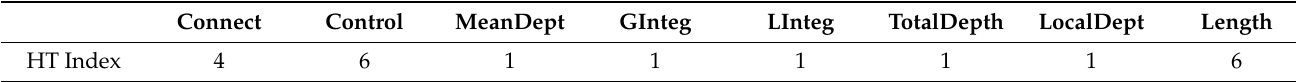
Table 2. Figure 5c space syntax metric and length HT